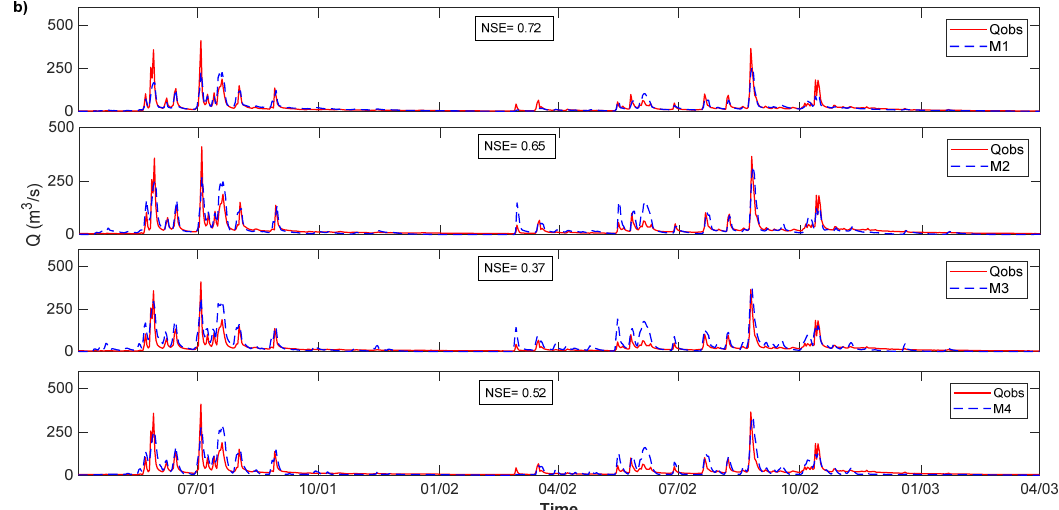
Figure 6. Comparison of observed and simulated streamflows for ( a ) CHC (sedimentary and flat watershed) and ( b ) in DSL (volcanic and steep watershed) (period April 2001–March 2003).